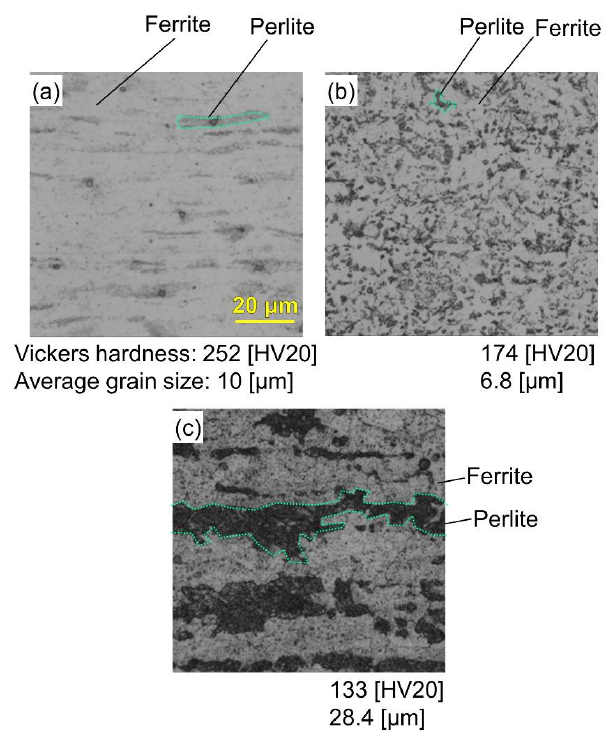
Figure 8. Microstructures of ( a ) as-received sheet, ( b ) normalised and ( c ) annealed 22MnB5 sheets.